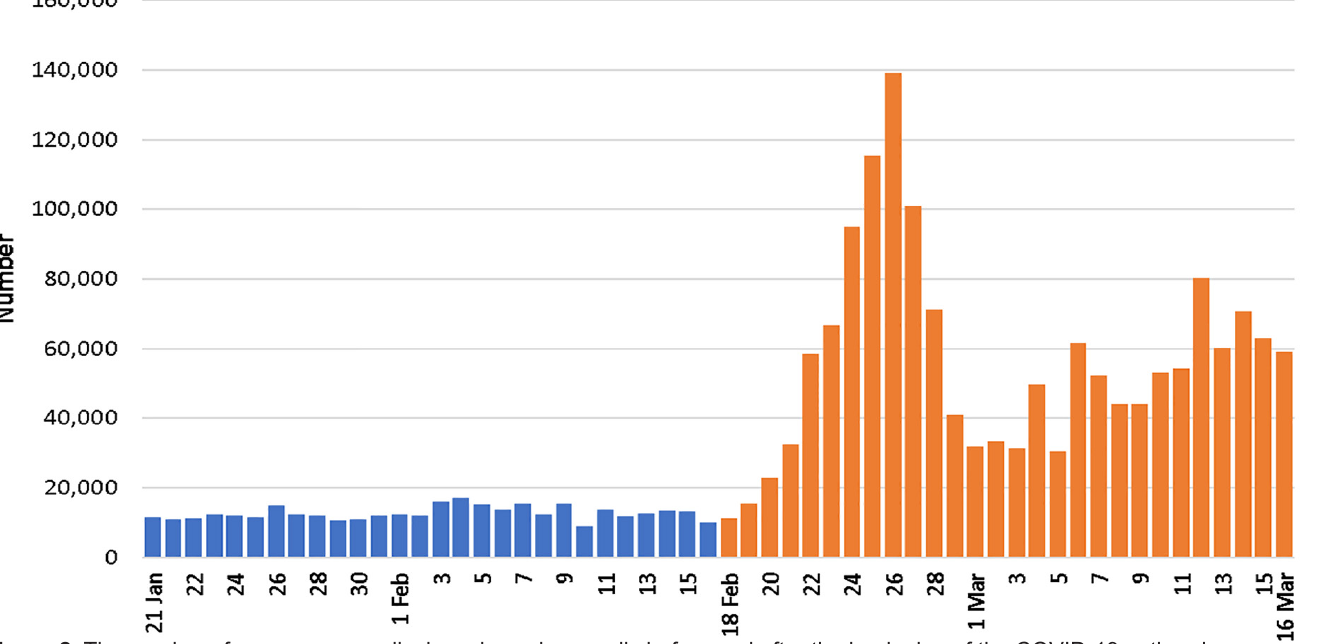
Figure 2. The number of emergency medical services phone calls before and after the beginning of the COVID-19